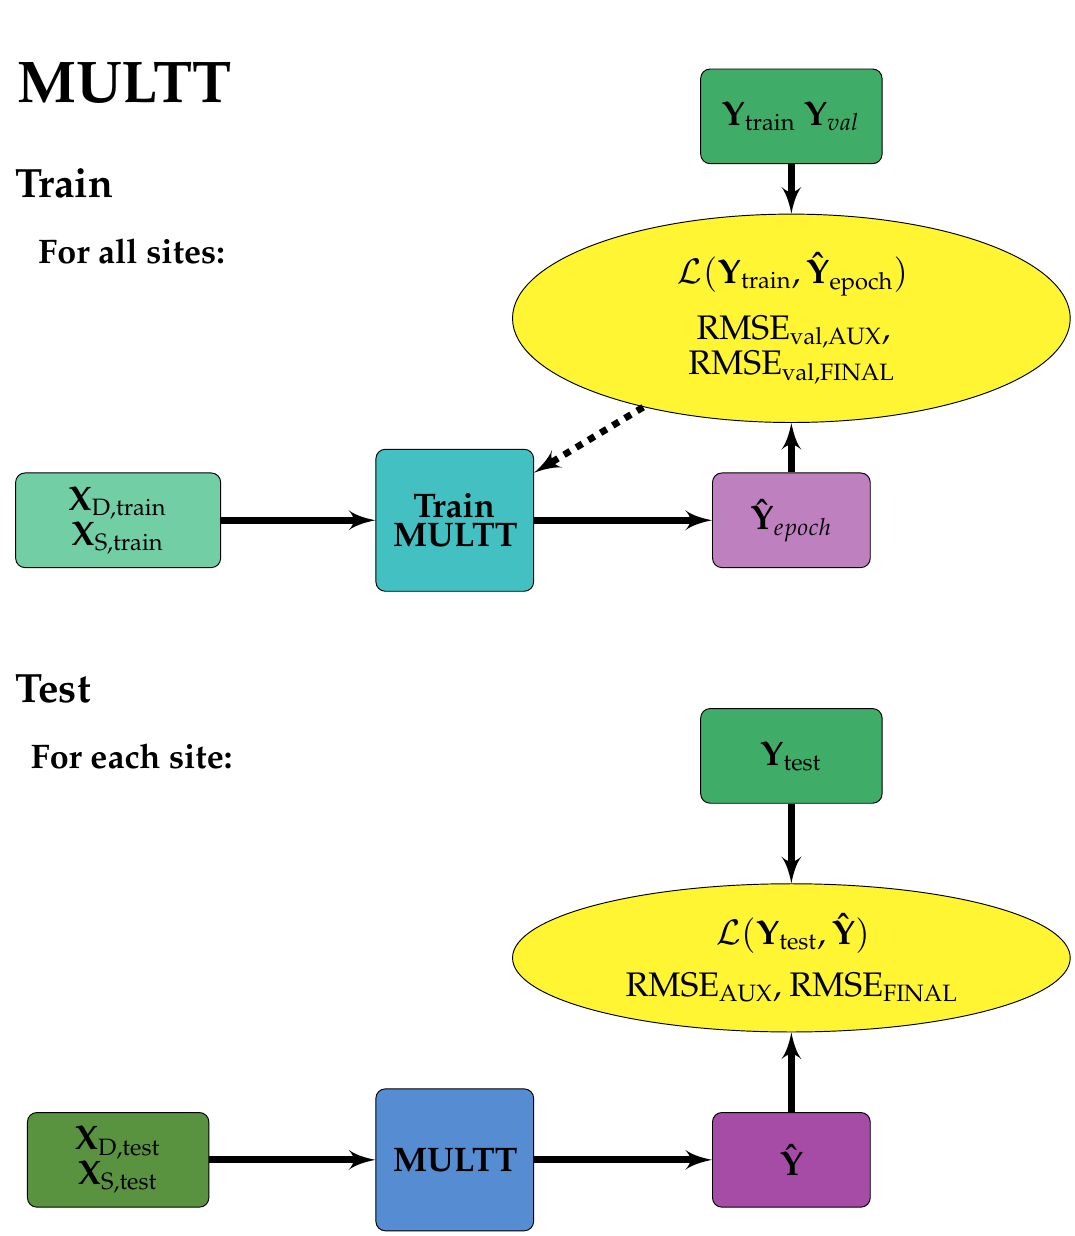
Figure 4. MULTT model design. Solid arrows indicate the forward flow of information, dashed arrows indicate information used to make updates to model weights and/or inform early stopping. Training data were from all sites, such that each tensor was a concatenation of training data from each site along the samples axis. The trained model was then applied to each site